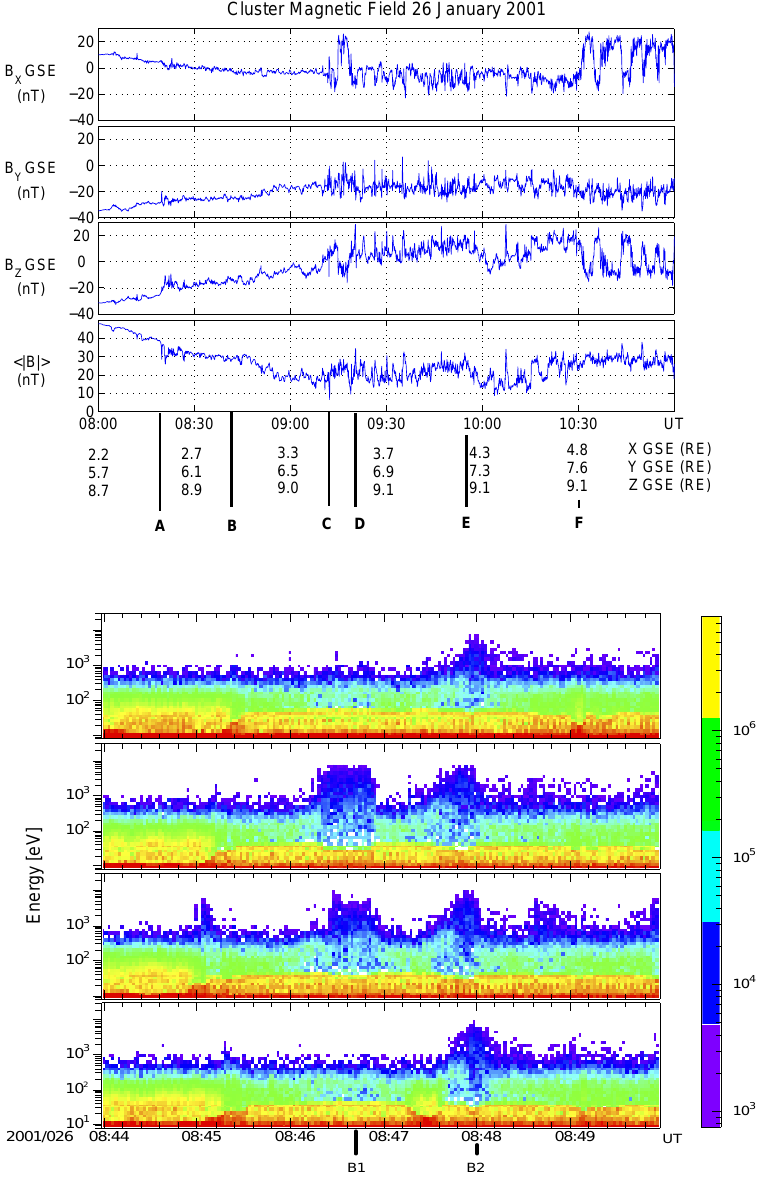
Fig. 6. Spectra from all four space- craft from 26 January 2001, 08:44– 08:49 UT, focusing on the region B in Fig. 3. Again, the spectra are a combi- nation of the HEEA and LEEA sensors, with Cluster 1 at the top and Cluster 4 at the bottom. The feature at ∼ 08:46:41 (labelled B1) is detected only at Clus- ter 2 and 3, followed by the event at ∼ 08:48:01 (labelled B2) detected at all four